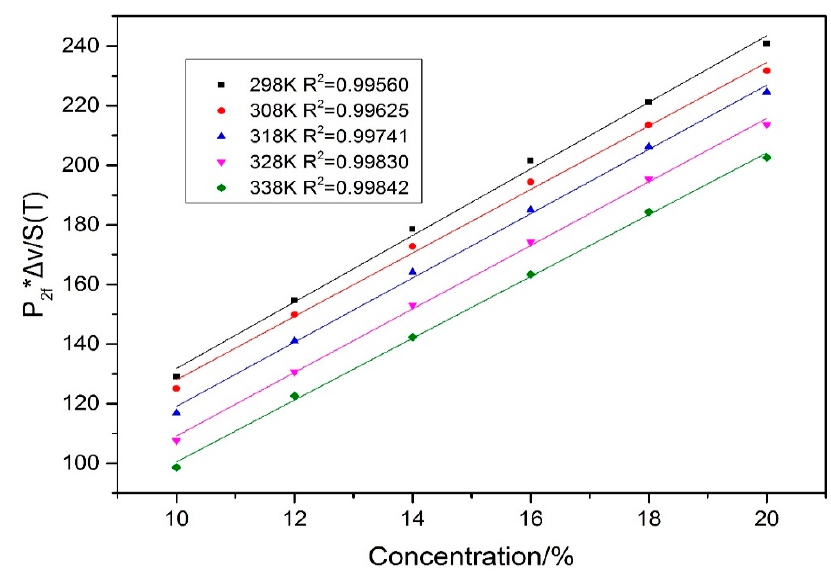
Figure 12. A linear fit of between P 2 f · ∆ ν c / S ( T ) and concentration at different temperatures (298–338 K). Table 3. The relative errors of wavelength modulation results before correction (298–338 K). Inferred Concentration True Concentration